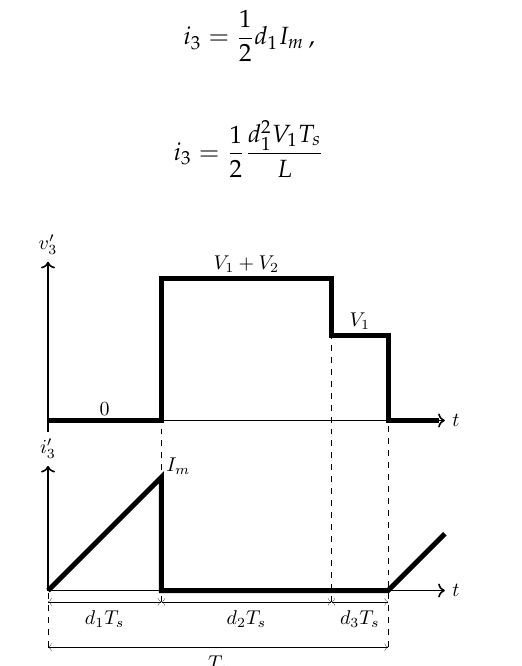
Figure 8. Voltage and current waveforms associated with S 1 for the equalizer circuit when V 1 > V 2